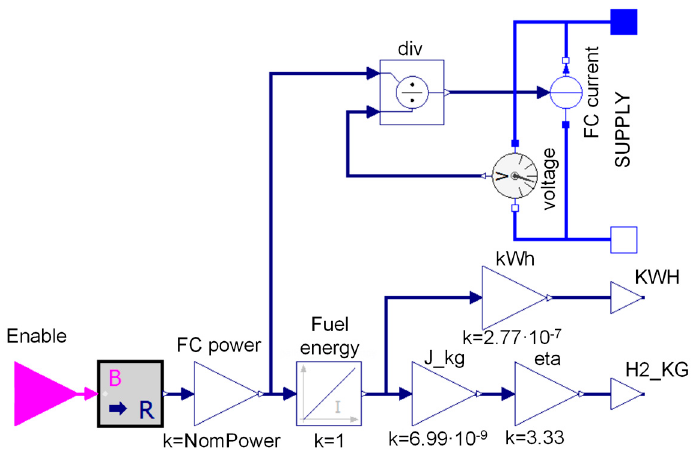
Energies 2020 , 13 , x FOR PEER REVIEW Figure 15. Model of electrical energy store developed in Modelica. Figure 15. Model of electrical energy store developed in Modelica. Figure 16. Model of a PEM hydrogen fuel cell developed in Modelica.